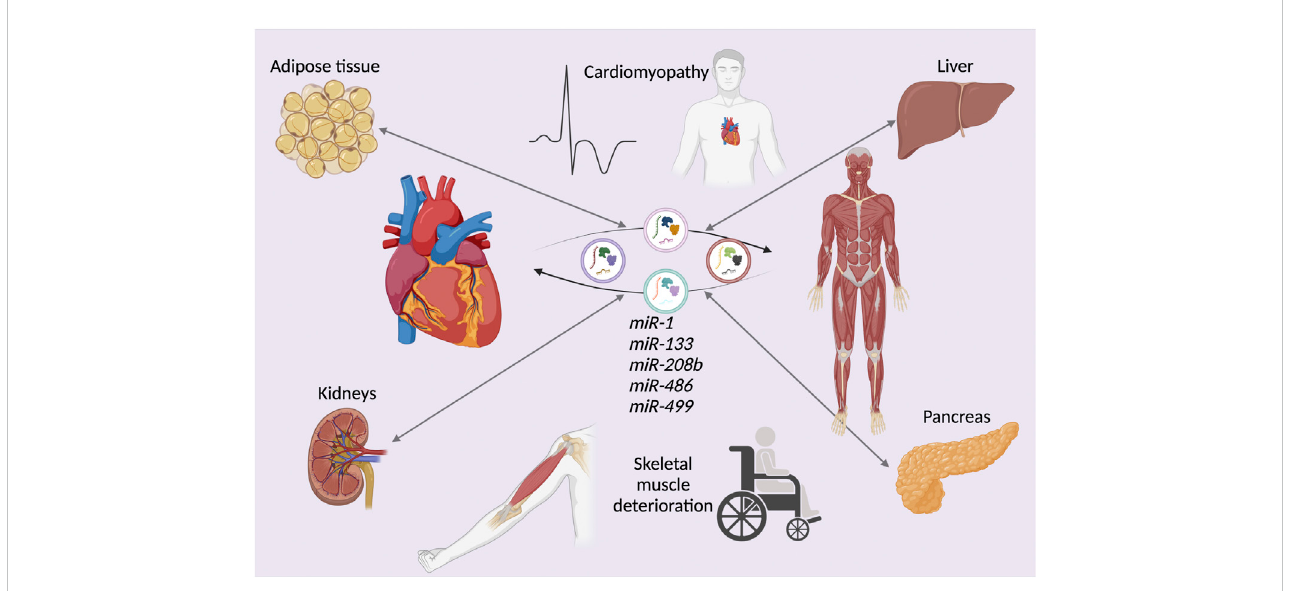
FIGURE 2 The deleterious effects of extracellular vesicle (EV)-mediated organ cross-talk. The exchange of microRNAs (miRNAs), either downregulated or upregulated inyoung andelderly Duchenne musculardystrophy(DMD)patients.The depictedmiRNAsrepresentexamples ofEVcargos exchanged between notonly cardiacand skeletalmuscle, but also various otherorgans andtissues suchas kidneys, pancreas, liver, andadiposetissue.This cross-talkexacerbates the DMD